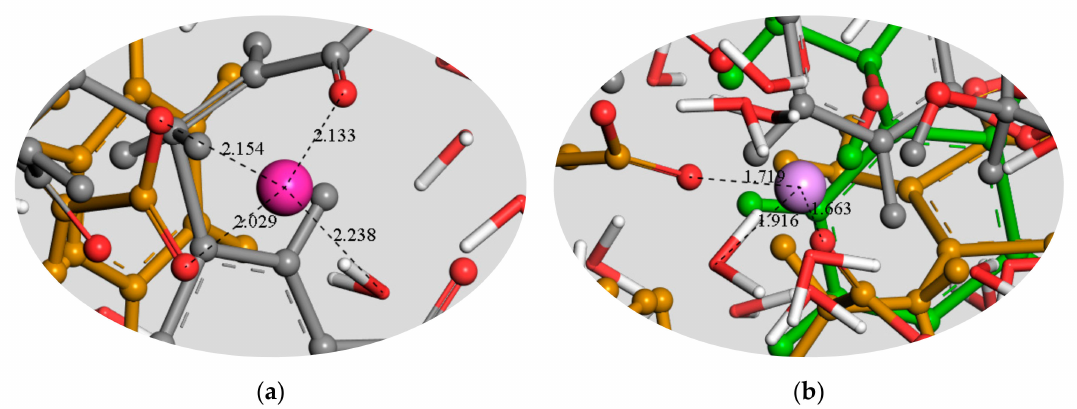
Figure 6. The coordination of TNB with ( a ) Ca 2 + and ( b ) Mg 2 + from snapshots of the molecular dynamics simulations. Ca 2 + (pink), Mg 2 + (purple), O (red). The coordination of water molecules with metal ions is represented by the ball stick model. The coordination between TNB and metal ions is represented by the ball bar model, the others are linear models, and the bond length is in